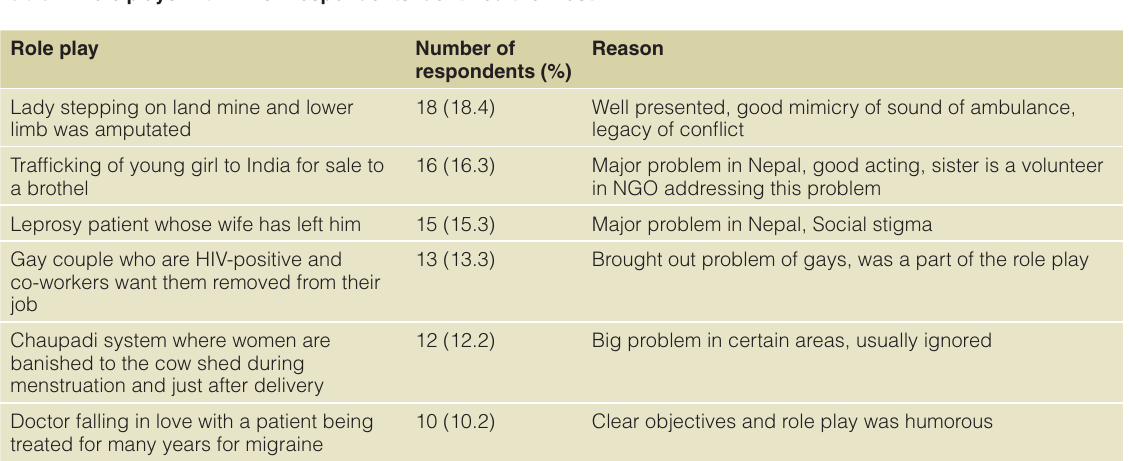
Table 4. Role plays with which respondents identified the most.